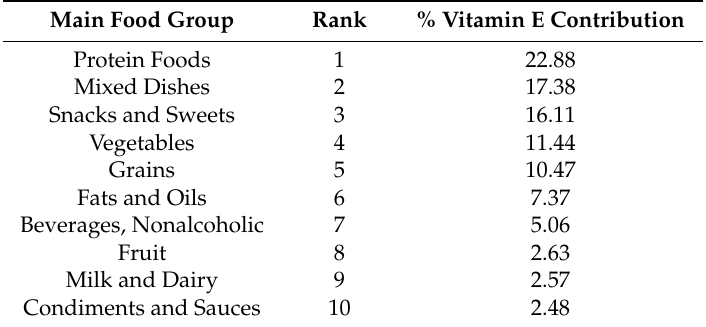
Table 11. Food sources of vitamin E, as alpha-tocopherol, contribution in the total U.S. diet, adults ≥ 51 years old ( n = 4522; gender combined; daily intake data; NHANES 2011–2014; main food groups contributing <1.0% not reported; data are Day 1 intakes).